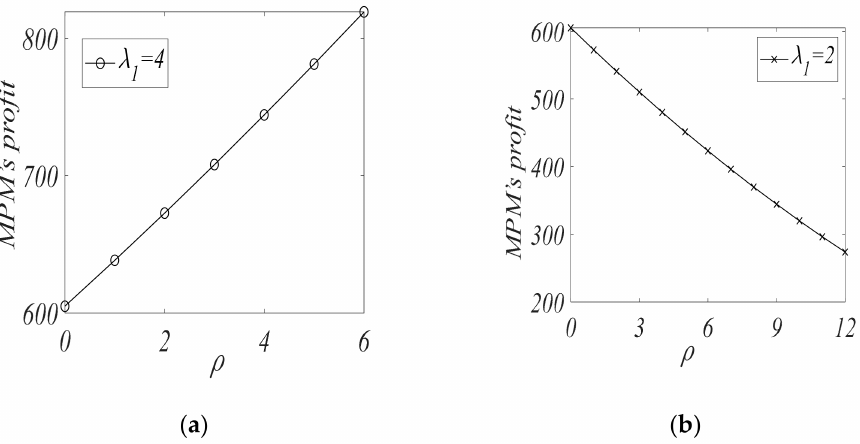
Figure 2. Impact of the recycling commission on the MPM’s profit under different customers’ preference of the recycling service: ( a ) When λ is strong ( λ 1 = 4); ( b ) When λ is weak ( λ 2 = 2).